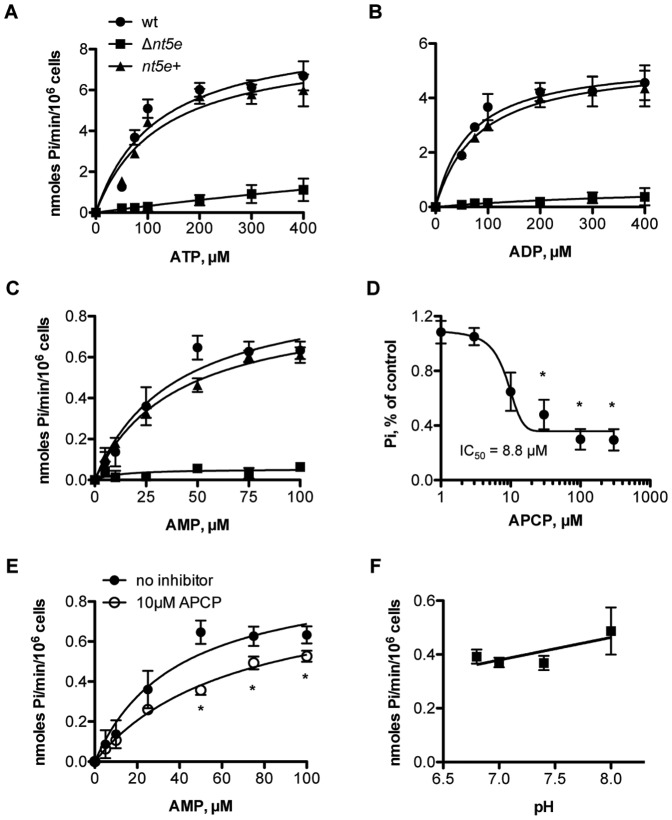
Characterization of Nt5e activity on S. sanguinis 133-79 whole cells.Nt5e activity was measured by the release of inorganic phosphate (Pi) from adenine nucleotides. For (A), (B), and (C), the Michaelis-Menten curves were showed as enzyme velocity (represented as nmole/min/106 cells) vs. concentration of ATP, ADP and AMP substrates. (D) Effect of Nt5e inhibitor APCP on AMPase activity of S. sanguinis 133-79. The curve was fitted to a sigmoidal inhibitory dose-response curve and the inhibitory concentration 50% (IC50) value derived from the curve fit was shown. (E) Michaelis-Menten curves of AMPase activity vs. substrate concentration in the absence and presence of APCP. (F) pH dependence of AMPase activity of Nt5e. Statistical analysis was performed using non-linear regression. The results were represented as mean±SE, n = 3; *significantly decreased compared to no inhibitor (P<0.05).